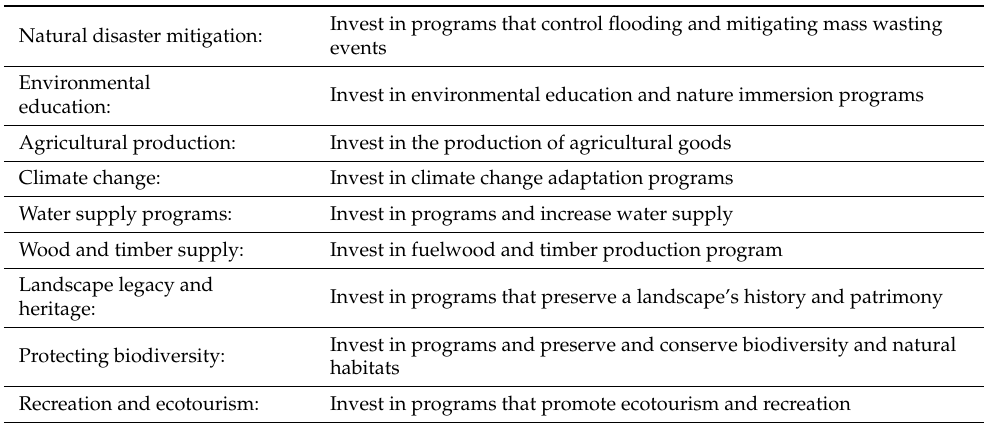
Table 1. The list of programs and policies in the survey questions regarding government investment in ecosystem services.